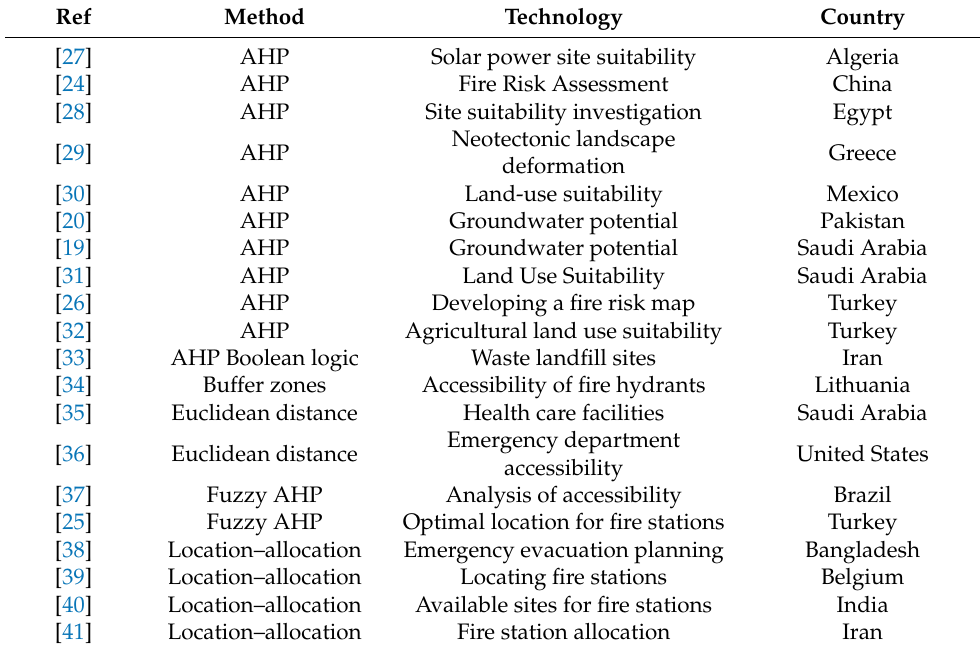
Table 1. Multi-Criteria Decision Analysis (MCDA) methods used in various